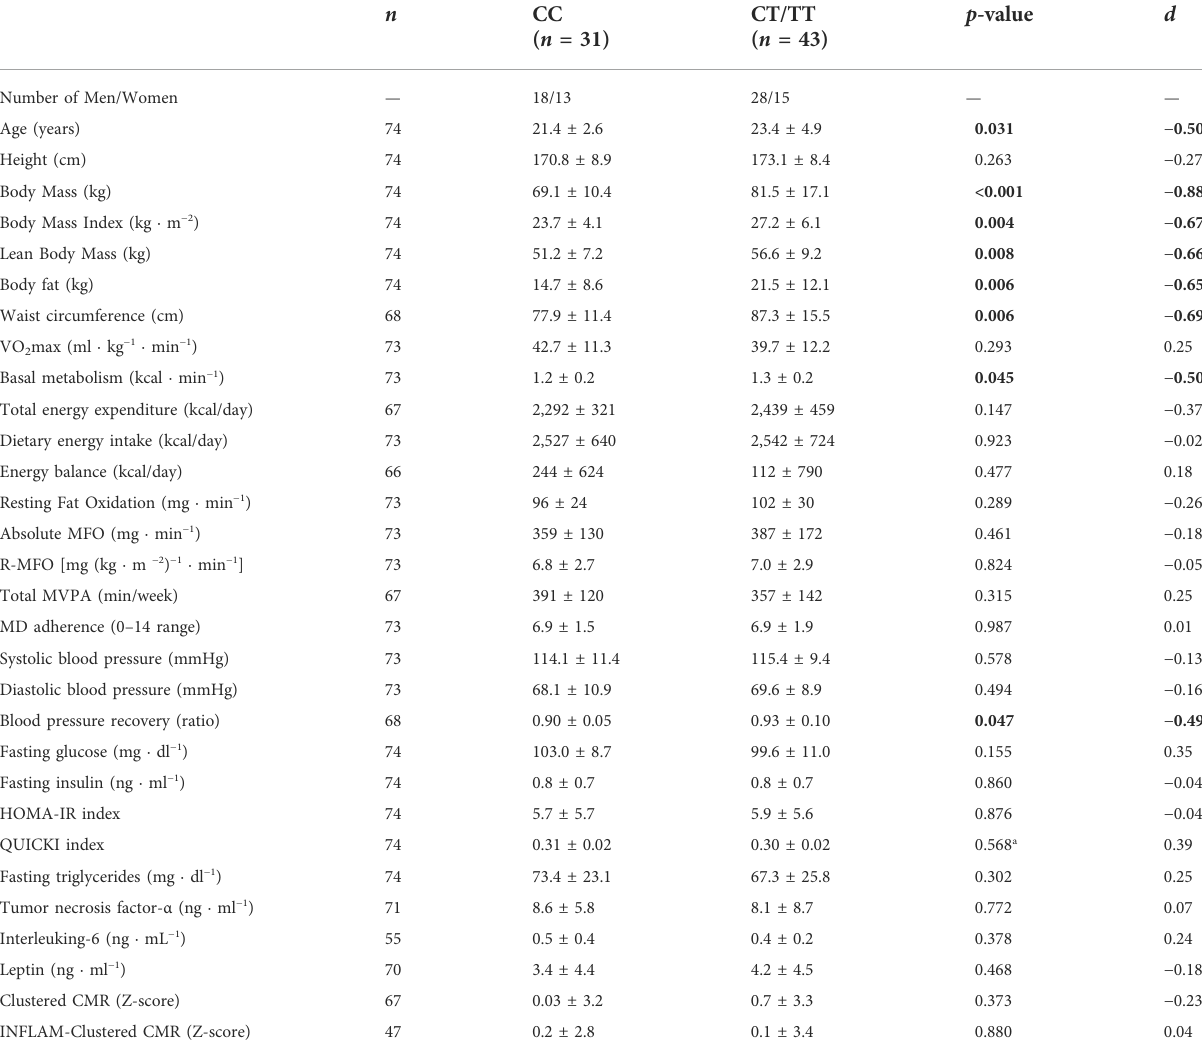
TABLE 3 Comparisons of the recessive model (CC vs. CT/TT) in the analyzed